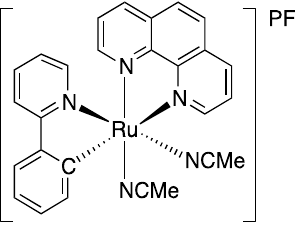
Figure 1. Chemical structure of the [Ru(o-C 6 H 4 -2-py)(phen)(MeCN) 2 ]PF 6 catalyst.